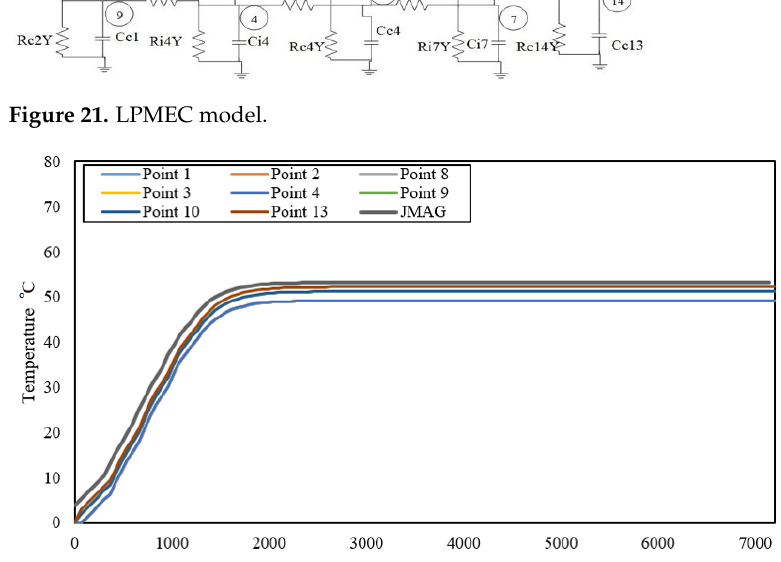
Figure 22. Thermal analysis of each